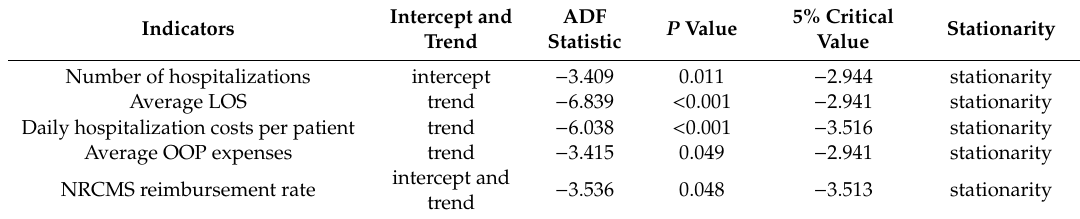
Table 3. Results of Augment Dicky-Fuller unit root test and stationarity of